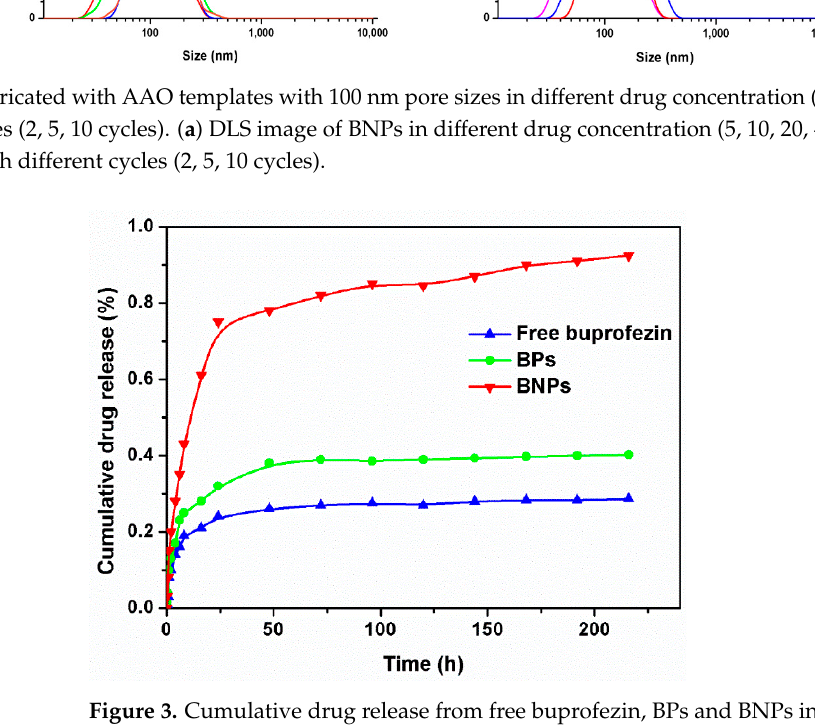
Figure 3. Cumulative drug release from free buprofezin, BPs and BNPs in PBS medium.